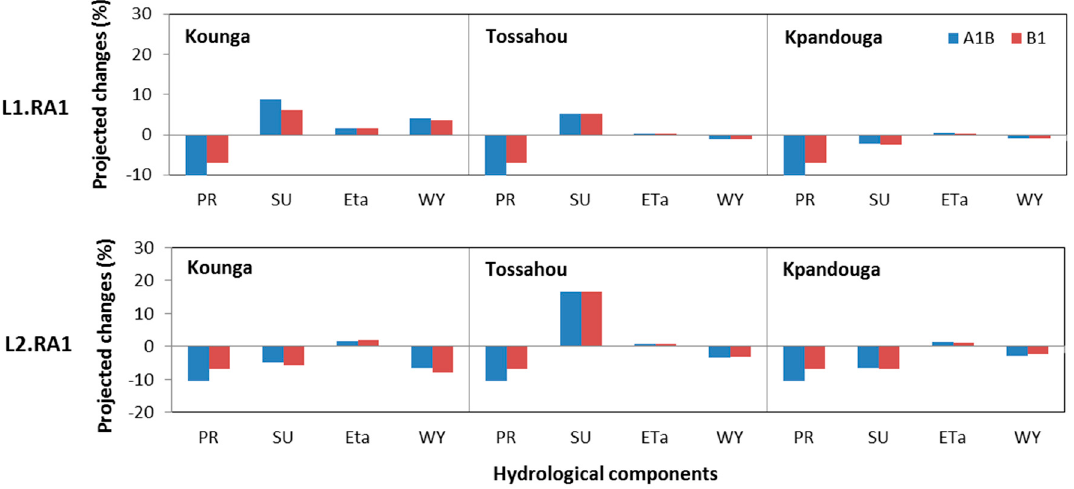
Figure 10. Relative changes induced by the development of the rainfed-bunded cultivation system compared to the current cultivation system with the use of fertilizers under land use and climate change scenarios from 2030 to 2049. L1 and L2 are land use change scenarios of 25% and 75% lowland conversion, respectively. RA1 is rainfed-bunded rice cultivation system with fertilizer application. A1B and B1 are climate change scenarios; ETa is actual evapotranspiration; SU is surface runoff; PR is precipitation; and WY is total water yield.